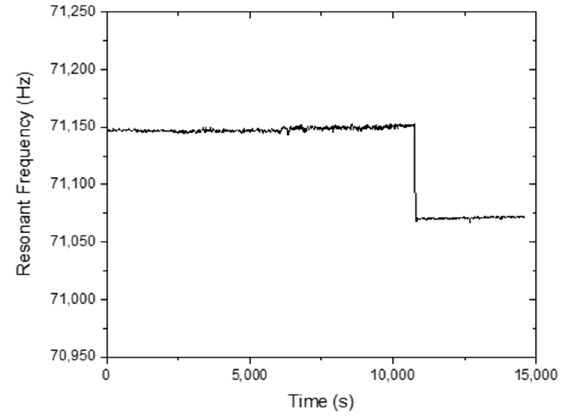
Figure 9. Long-term frequency variation of MES-1 at two different 77.5% and 95% RH levels.